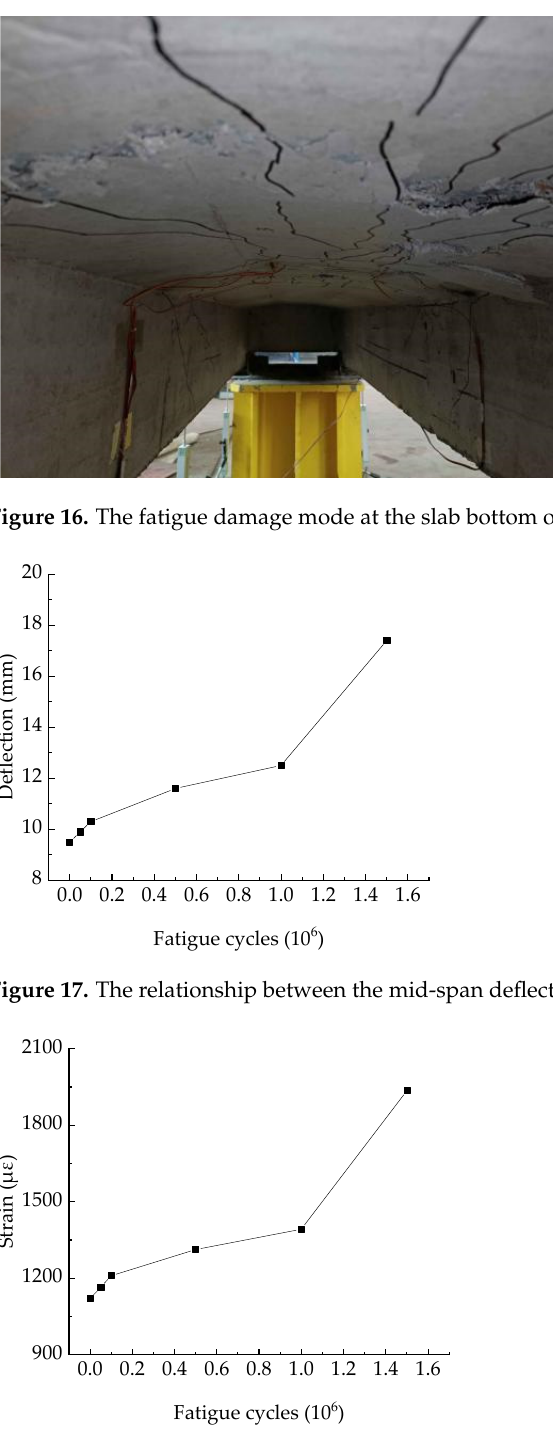
Figure 15. The damage mode at the slab bottom of P1 under static loads.